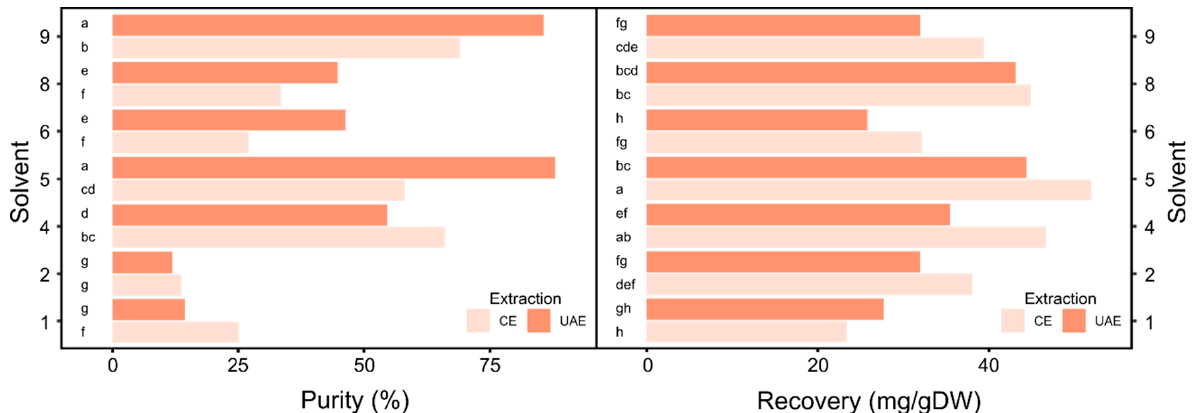
Figure 3. Mean of MPTOX purity ( right ) and recovery ( left ) obtained with UAE and CE from L. dolomiticum ARc. Samples with different letters are significantly different at p ≤ 0.05 according to Duncan test. Coefficient of variation (CV), purity = 13.3%; recovery = 7.5%. n= 3.